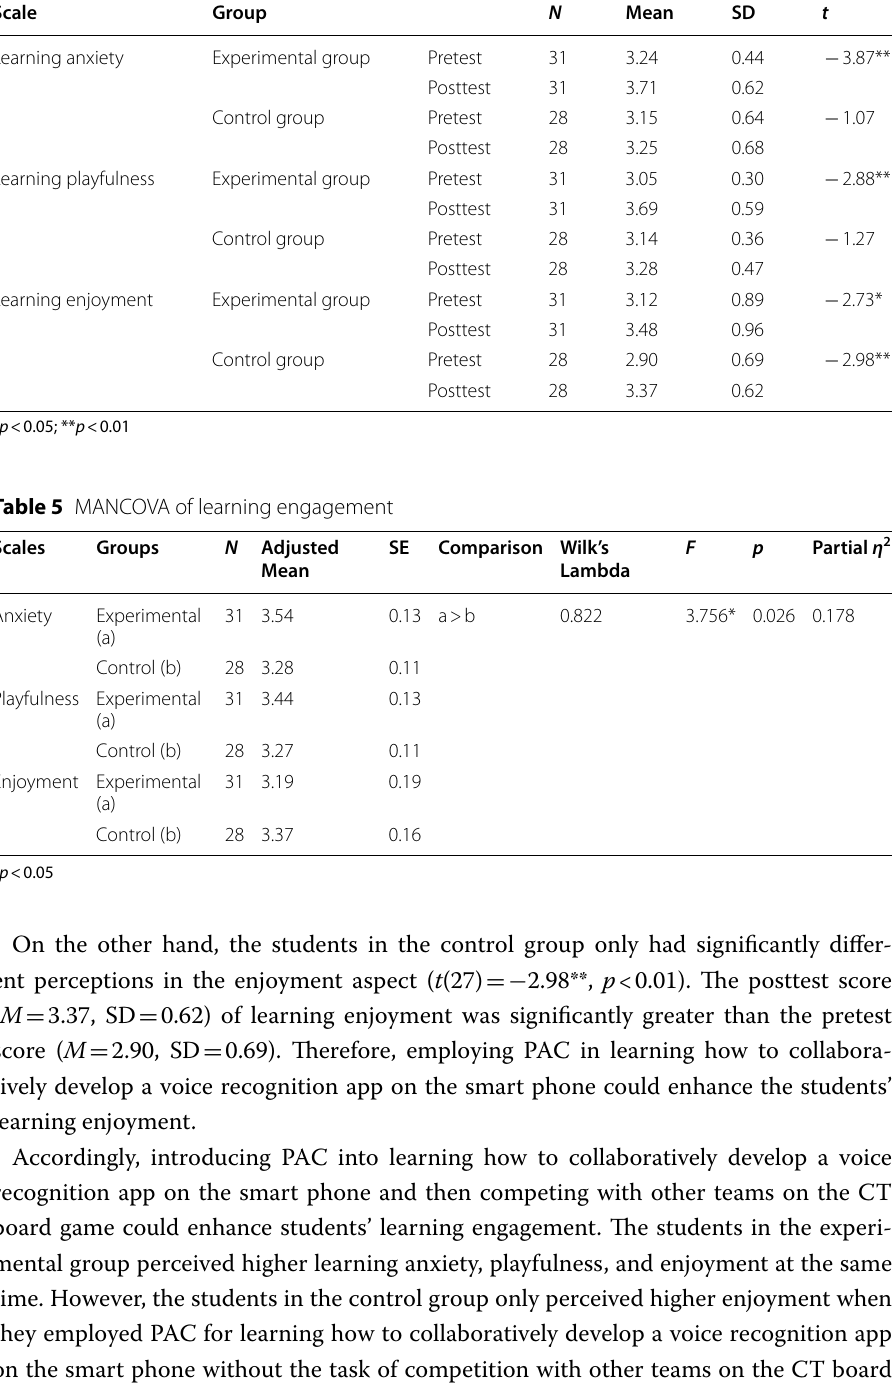
Table 4 Paired‑sample t test between the pre‑ and posttests of learning engagement with learning anxiety, playfulness, and enjoyment for the experimental and control groups